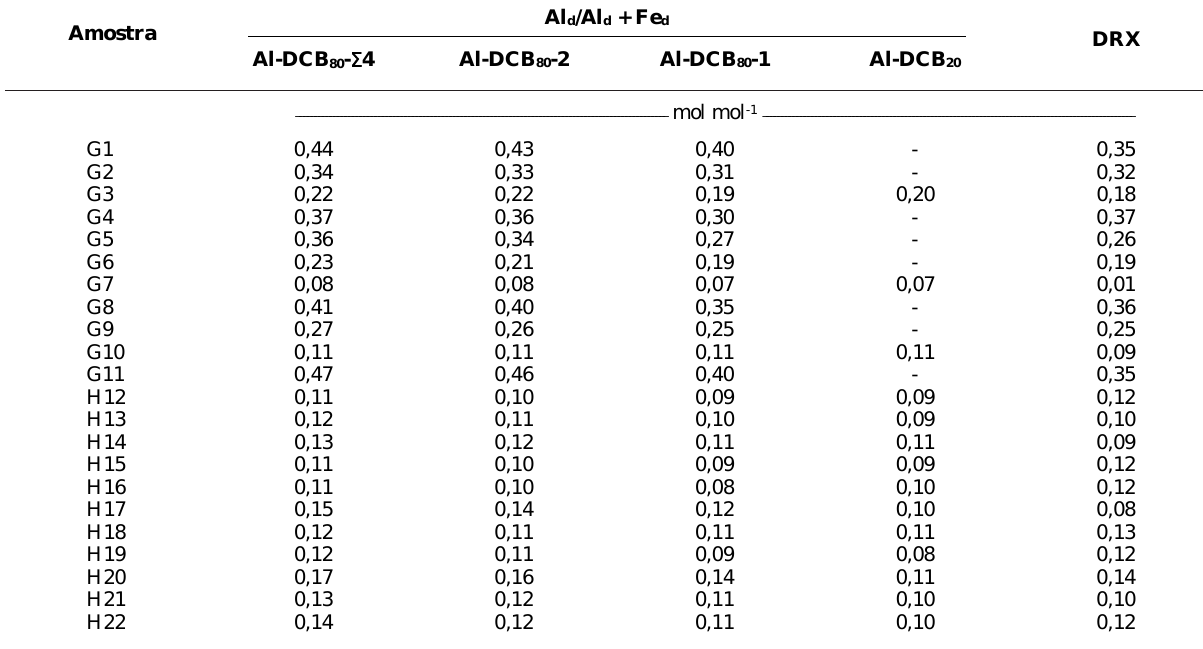
Quadro 4. Valores da relação Al DCB , na primeira, segunda e quarta extrações, e o Al-DCB 80 de raios X